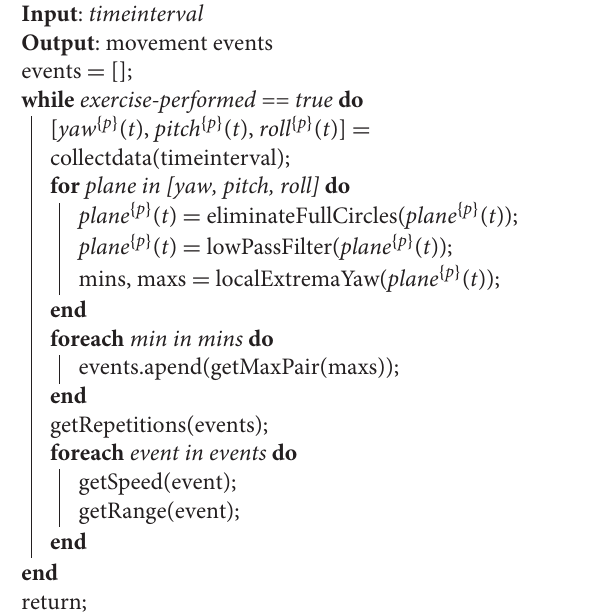
Algorithm 1 collects data from the sensing devices every timeinterval milliseconds. For this batch, it applies a “full circle”